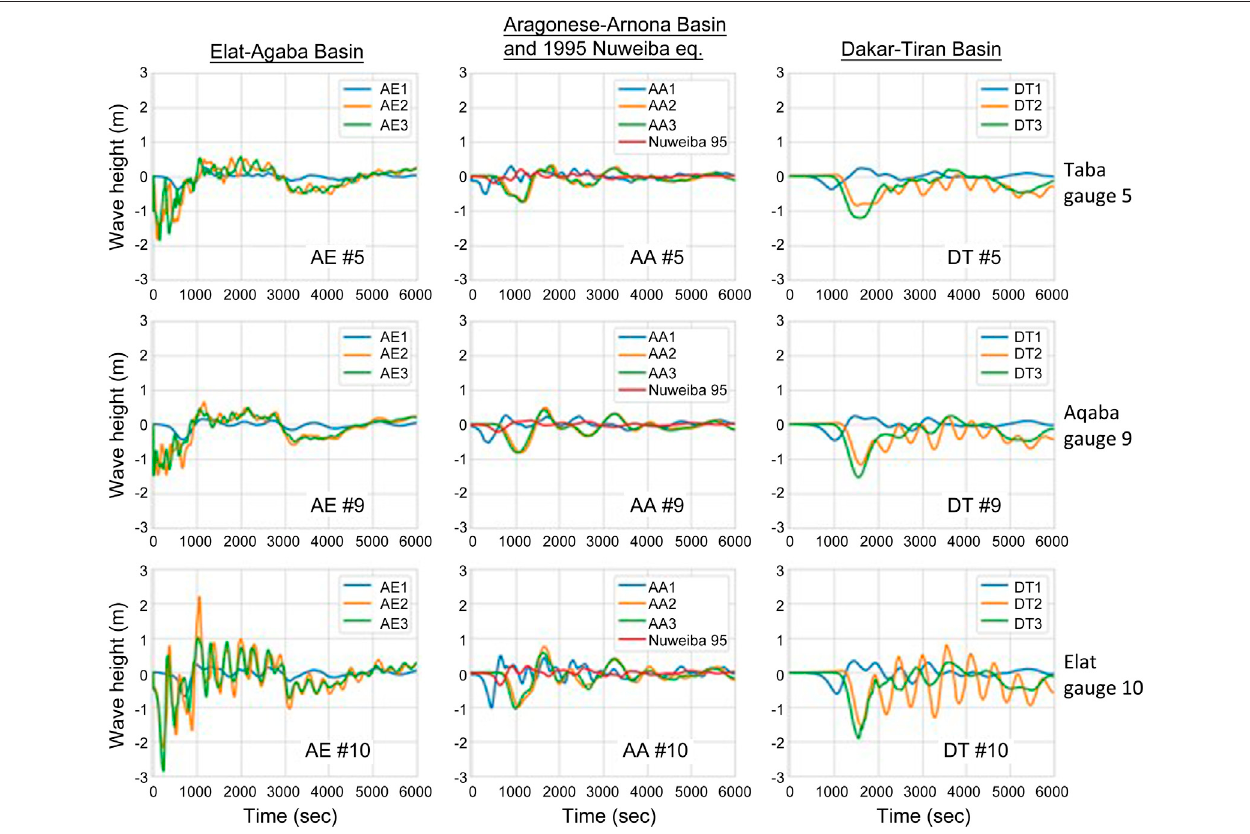
FIGURE 5 | Waveforms of the simulated tsunami scenarios recorded by arti fi cial tide gauges in the head of the Gulf of Elat – Aqaba (HGEA) region. Each diagram presentswaveformsofthreescenariossimulatedinthegivenbasin(orderedbycolumns)asrecordedbythegiventidegauge(orderedbyrows).Theleftcolumnpresents scenario waveforms propagated from Elat-Aqaba Basin (denoted AE), the central column shows waveforms generated in Aragonese-Arnona Basin (AA) and calculated waveformofthe1995NuweibaM7.2tsunami,therightcolumnwavesarrivingfromDakar-TiranBasin(DT).Therowsarrangedbywaveformsrecordedinthegiven gauge: upper row for Taba (#5), central for Aqaba (#9) and lower for Elat (#10).